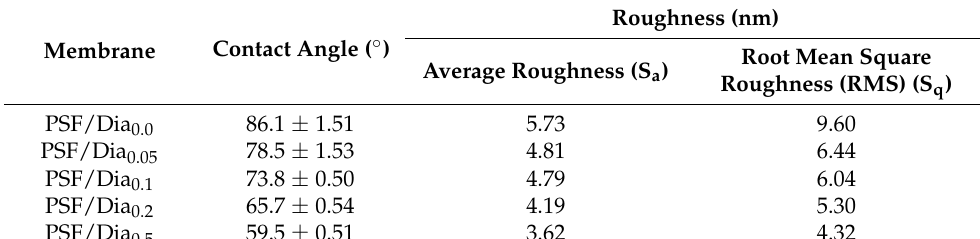
Table 2. Contact angle and surface roughness values of diatomite-embedded PSF composite mem- branes.